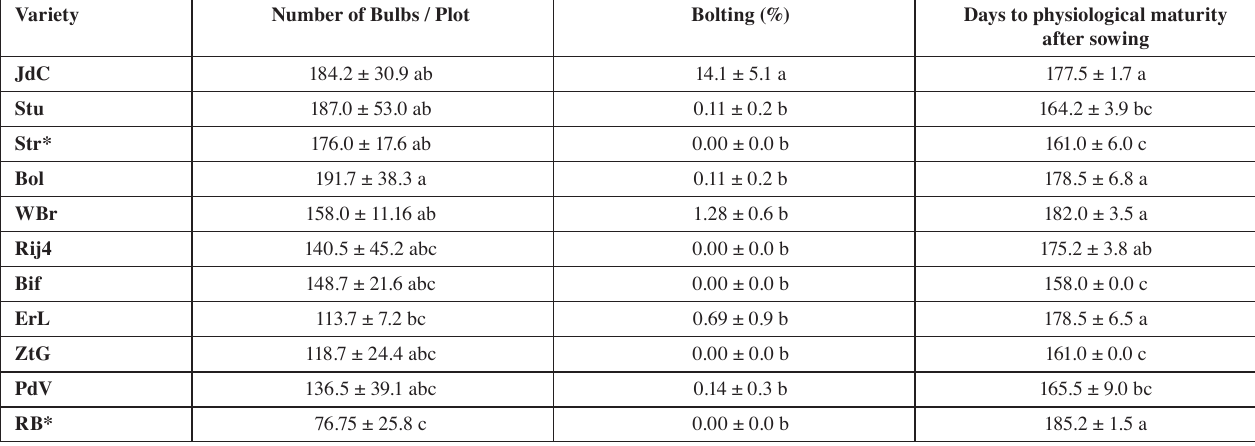
Tab. 2: Agronomic parameters of the varieties.